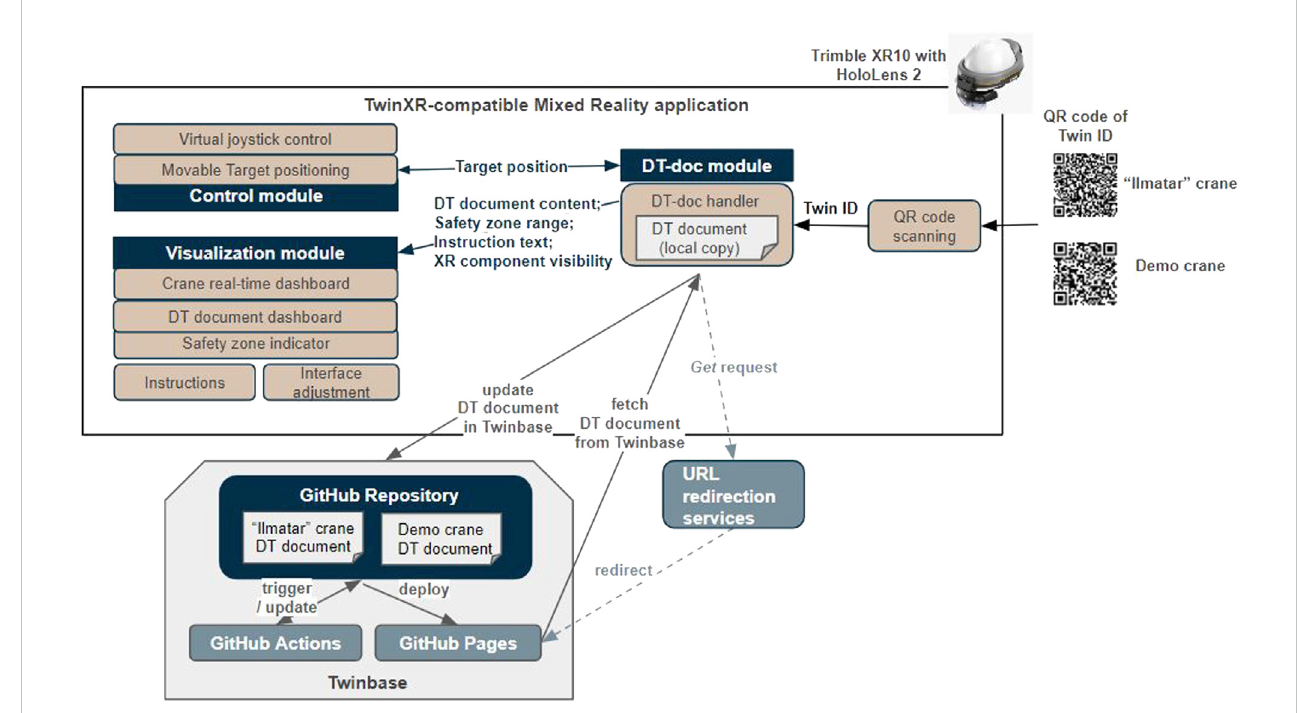
FIGURE 4 ArchitectureoftheTwinXRmethodimplementationforcraneoperationwithaTwinXR-compatibleMRapplication,andaTwinbaseserverwithcraneDT